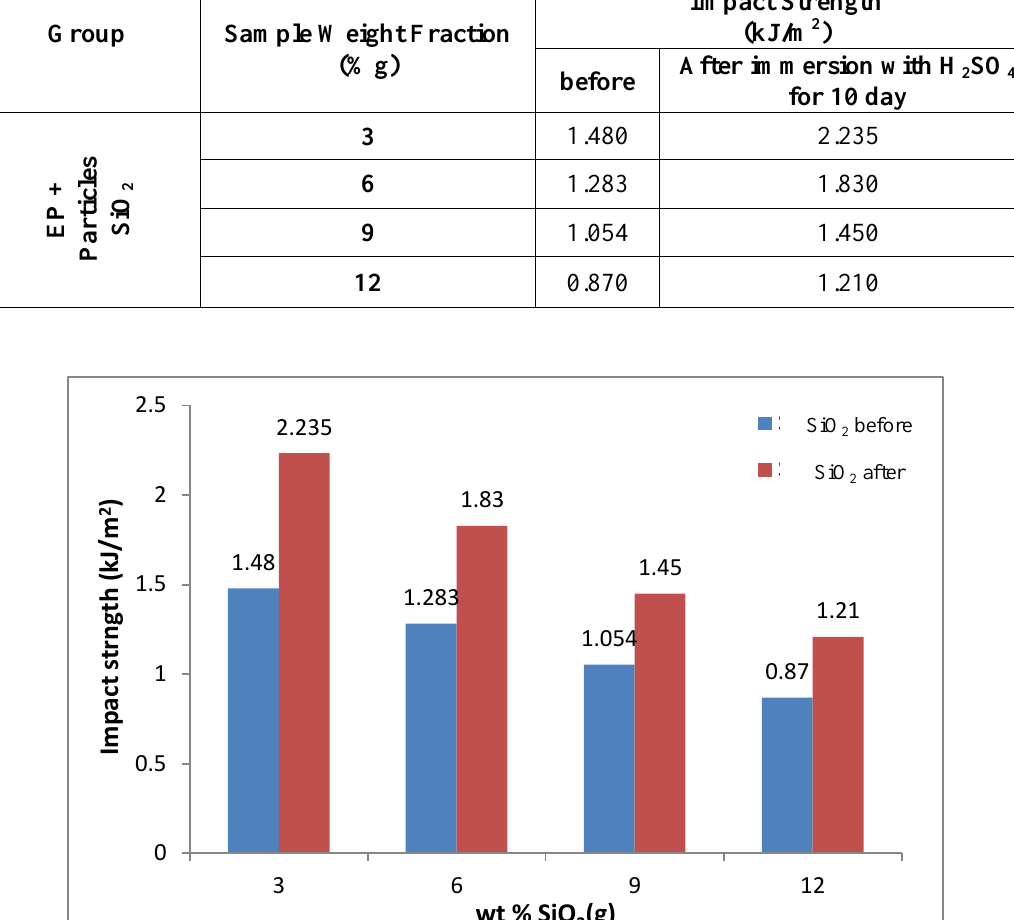
Table 3: shows the results of the Impact strength values of SiO immersion in sulfuric acid at normality of 0.3N for 10 days.